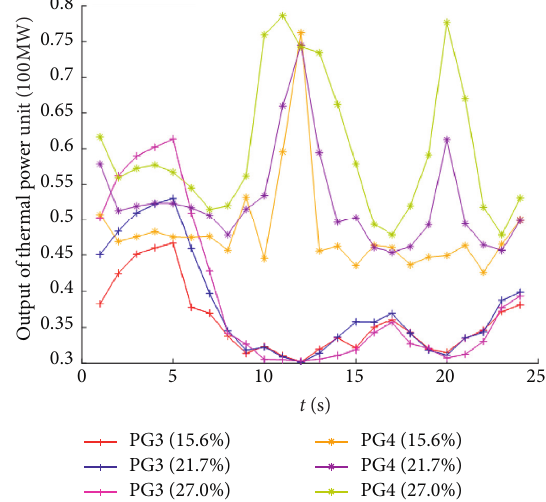
Figure 6: Comparison of thermal power units actual output under different wind penetration rates in Case